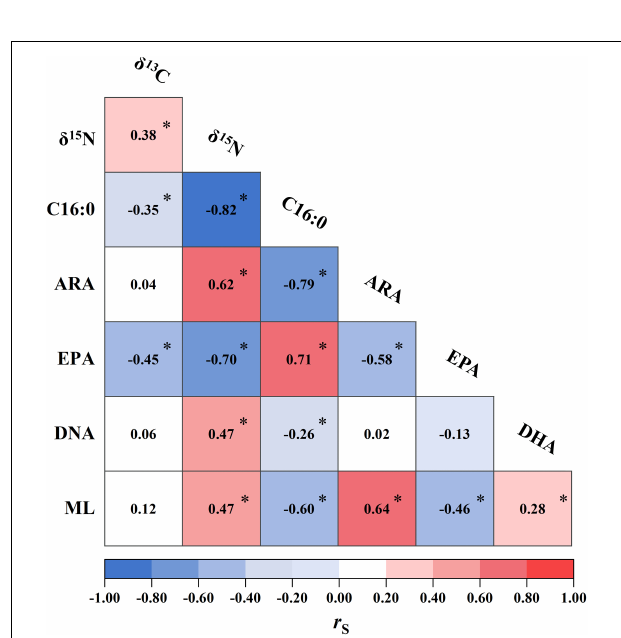
FIGURE 4 | Correlations between isotopic values ( δ 13 C and δ 15 N, %), fatty acids [palmitic acid (C16:0), arachidonic acid (ARA), docosahexaenoic acid (DHA), and eicosapentaenoic acid (EPA),% of total fatty acids], and mantle length (ML, cm) of Dosidicus gigas . The numbers inside grids are the associated Spearman’s rank correlation coefficient (rs) calculated for each pair. Statistical significance at ∗ p < 0.05 is